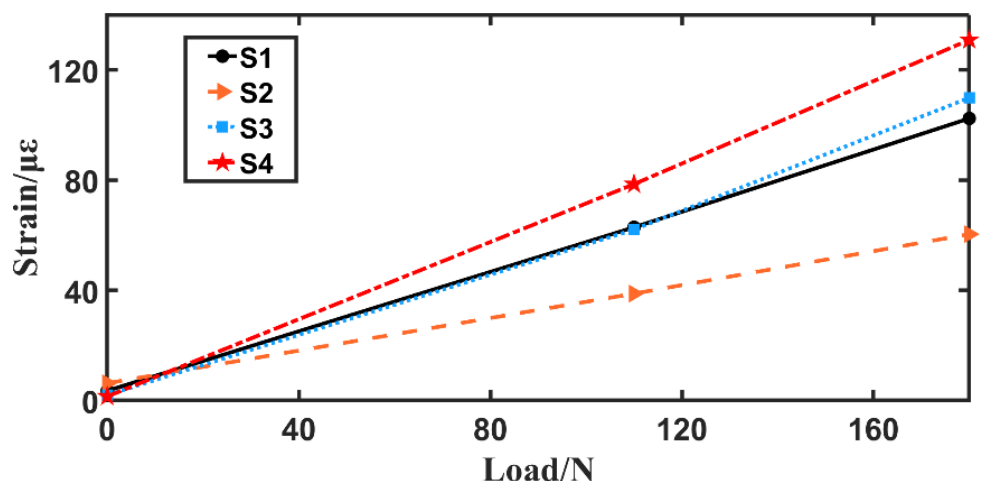
Figure 6. The static load–strain relationship of single pylon.